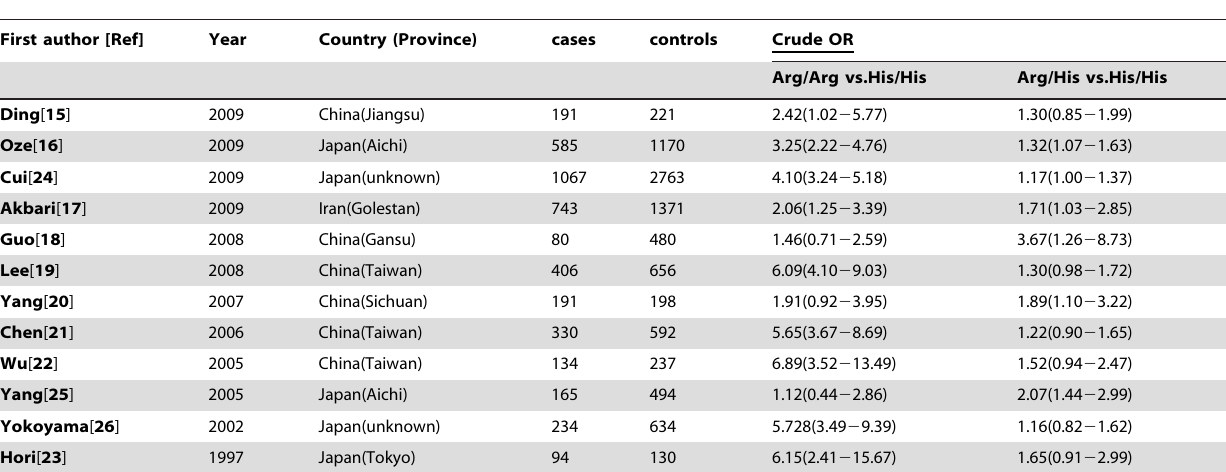
Table 1. Information of studies included in meta-analyses of ADH1B Arg47His polymorphism on ESCC risk.